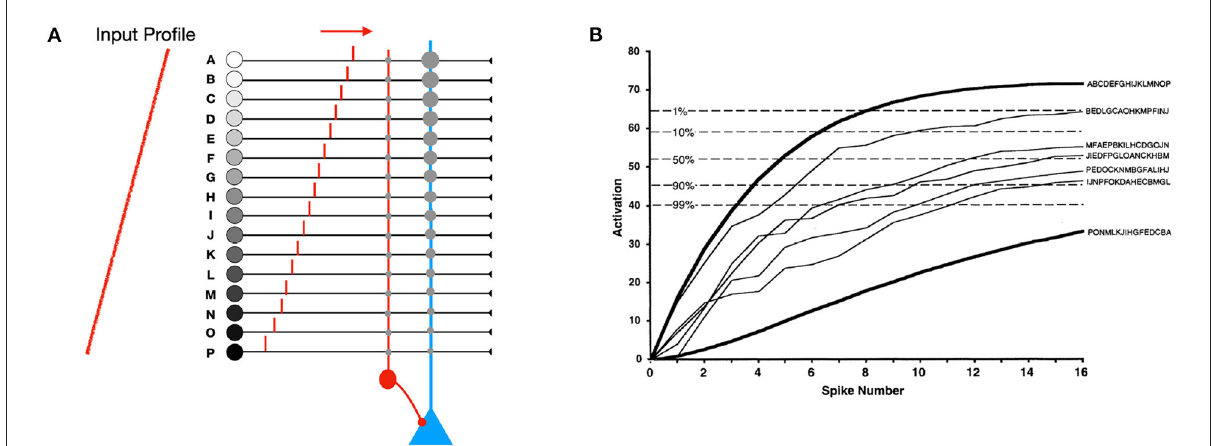
FIGURE1 (A) Rank order coding (ROC) with M 16 afferents. All the afferents fire exactly one spike. Here we show a neuron selective to the input spike = order: A, B, ... , P. Its synaptic weights are linearly decreasing: M for input A, M 1 for input B, and so on, down to 1 for input P. The modulation − decreases geometrically with the input spike rank. In practice, this modulation could be implemented with shunting inhibition, as shown with the red inhibitory neuron. (B) The increase in activation level depends on the order of firing. Maximal activation occurs when the inputs fire in the order of the weights (A, B, ... , P). Activation is minimal when the order is reversed. Intermediate lines correspond to 5 randomly selected